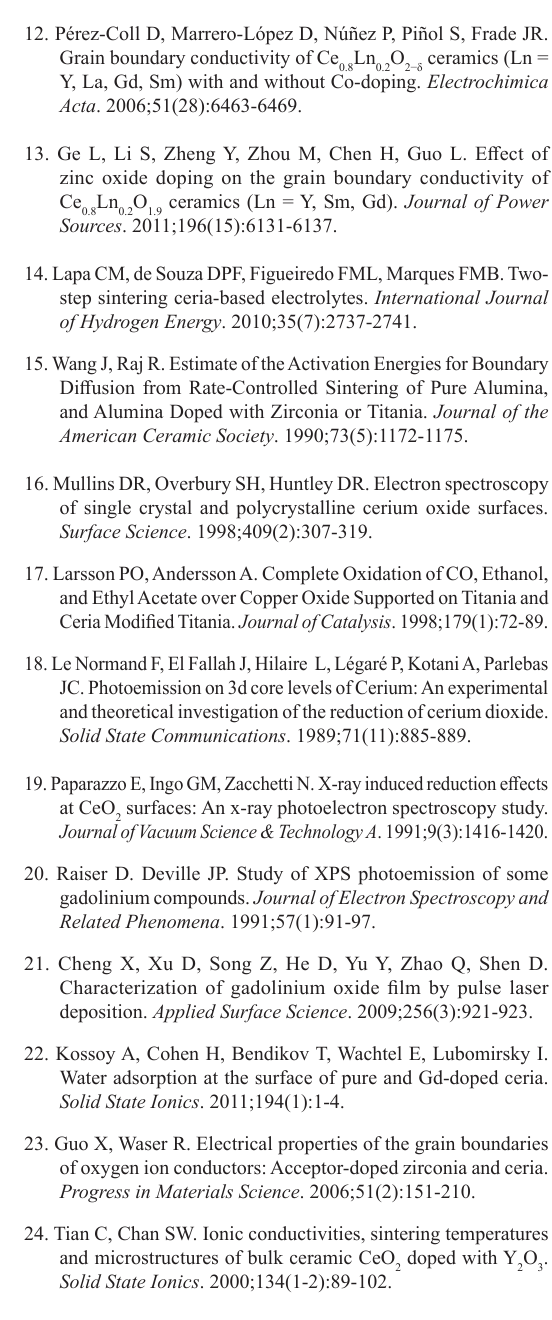
) in air of sample sintered at 1200-1000 °C /10h. at